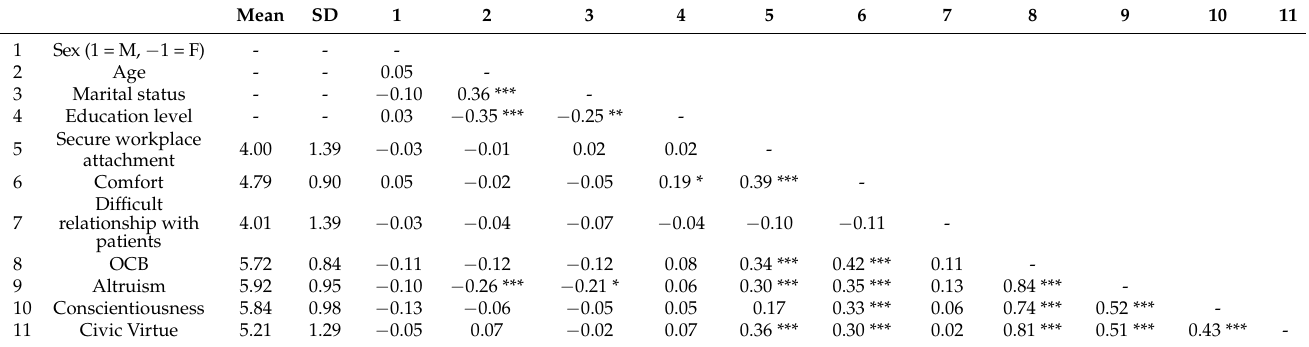
Table 1. Means, SDs and bivariate correlations of the study variables, and alpha in